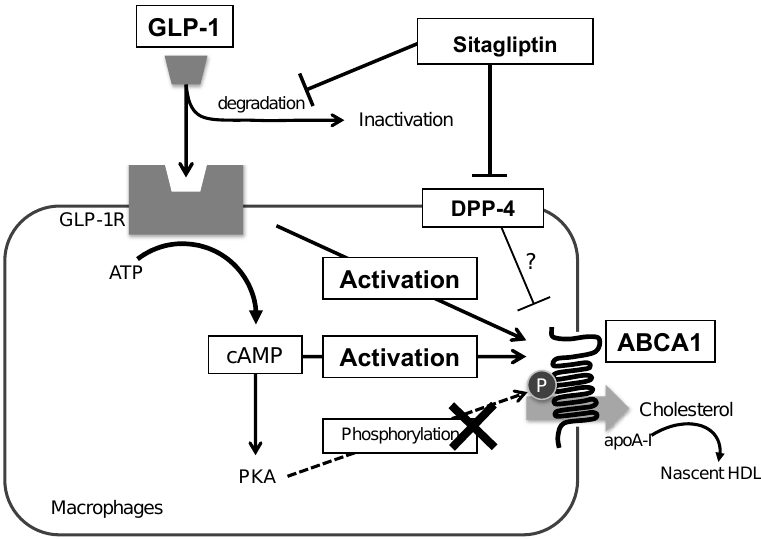
Figure 6. Graphical abstract for this study. Abbreviations: GLP-1, glucagon-like peptide-1; DPP-4, dipeptidyl peptidase-4; ABCA1, adenosine triphosphate-binding cassette transporter A1; PKA, protein kinase A; HDL, high-density lipoproteins.